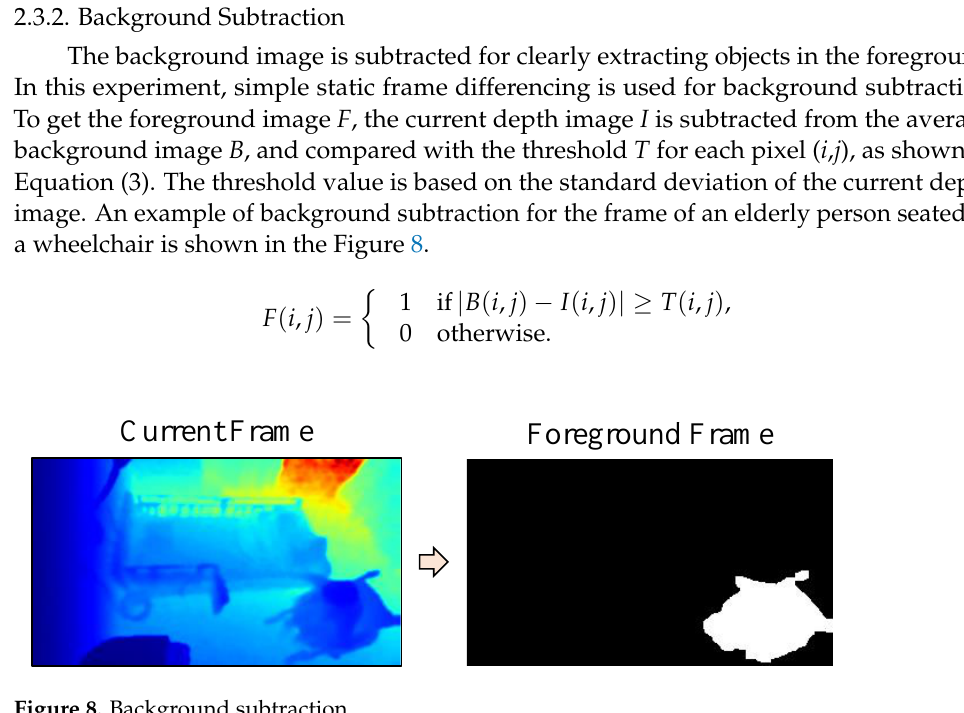
Figure 8. Background subtraction.